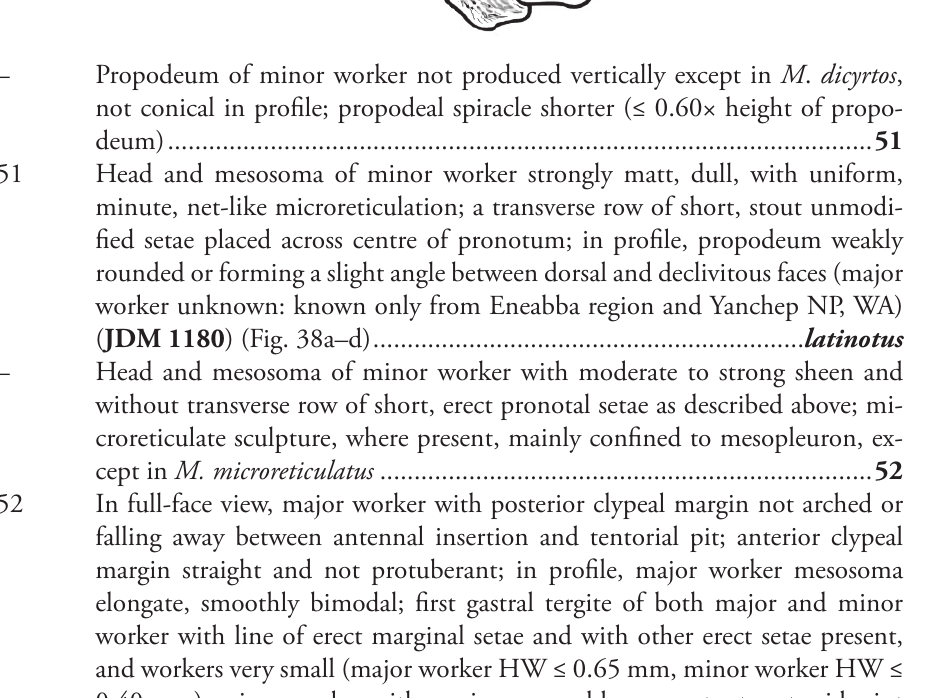
croreticulate sculpture, where present, mainly confined to mesopleuron, ex- cept in M. microreticulatus ........................................................................ 52 52 In full-face view, major worker with posterior clypeal margin not arched or falling away between antennal insertion and tentorial pit; anterior clypeal margin straight and not protuberant; in profile, major worker mesosoma elongate, smoothly bimodal; first gastral tergite of both major and minor worker with line of erect marginal setae and with other erect setae present, and workers very small (major worker HW ≤ 0.65 mm, minor worker HW ≤ 0.40 mm); minor worker with a pair or several long, erect setae at